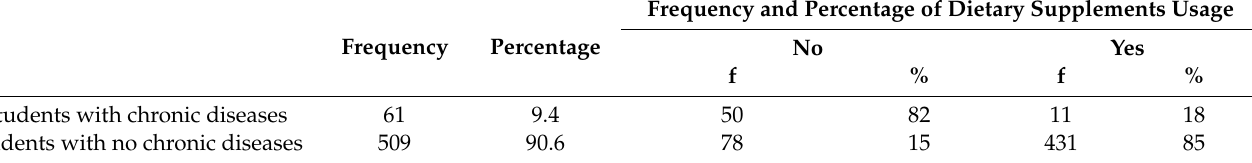
Table 3. Dietary supplement usage among